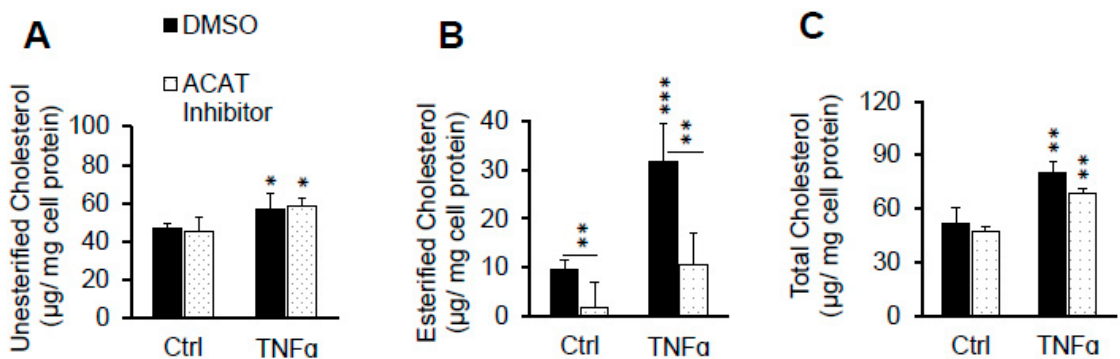
Figure 2. ACAT inhibitor does not prevent TNF α -induced LDL cholesterol accumulation. Cells in serum-free medium were treated with 0 or 100 ng/mL TNF α in the presence of 0.1% DMSO (DMSO) or 10 µ g/mL ACAT inhibitor (Sandoz 58-035) and 100 µ g/mL LDL for 24 hrs. After washing with heparin as described under Materials and Methods, the cellular cholesterol content was determined. ( A ) unesterified cholesterol, ( B ) esterified cholesterol, and ( C) total cholesterol. n = 3. *, **, ***, p < 0.05, 0.01, 0.001, relative to corresponding Ctrl or as indicated with bars.